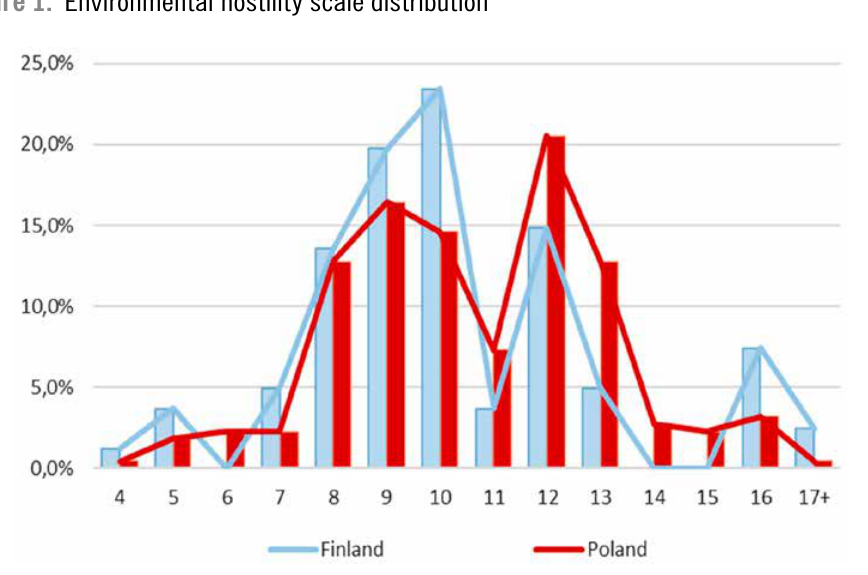
Figure 1. Environmental hostility scale